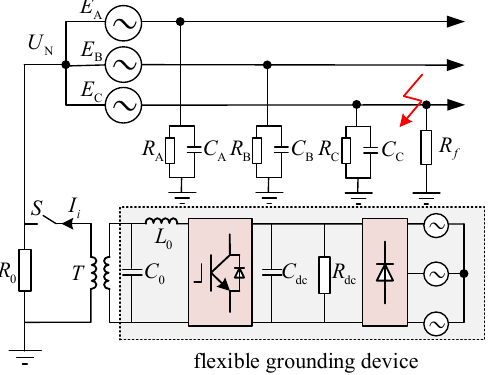
Figure 1. Topology of flexible grounding device.